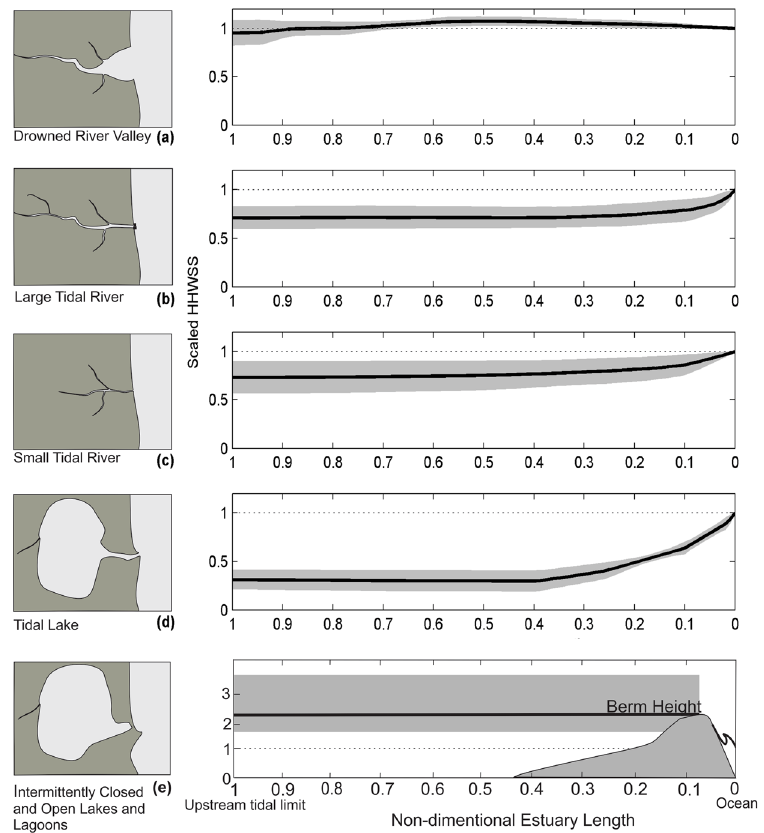
Figure 1. Average dimensionless tidal planes for five of the six estuary types used in this study. The sixth type were ocean embayment’s, where no tidal modification was assumed. The grey envelopes show the bounds of tide gauge data for all gauged estuaries of each estuary type. The dotted lines show the equivalent tidal plane using a bath tub approach. The non-dimensional estuary length is calculated by scaling the actual estuary length for each